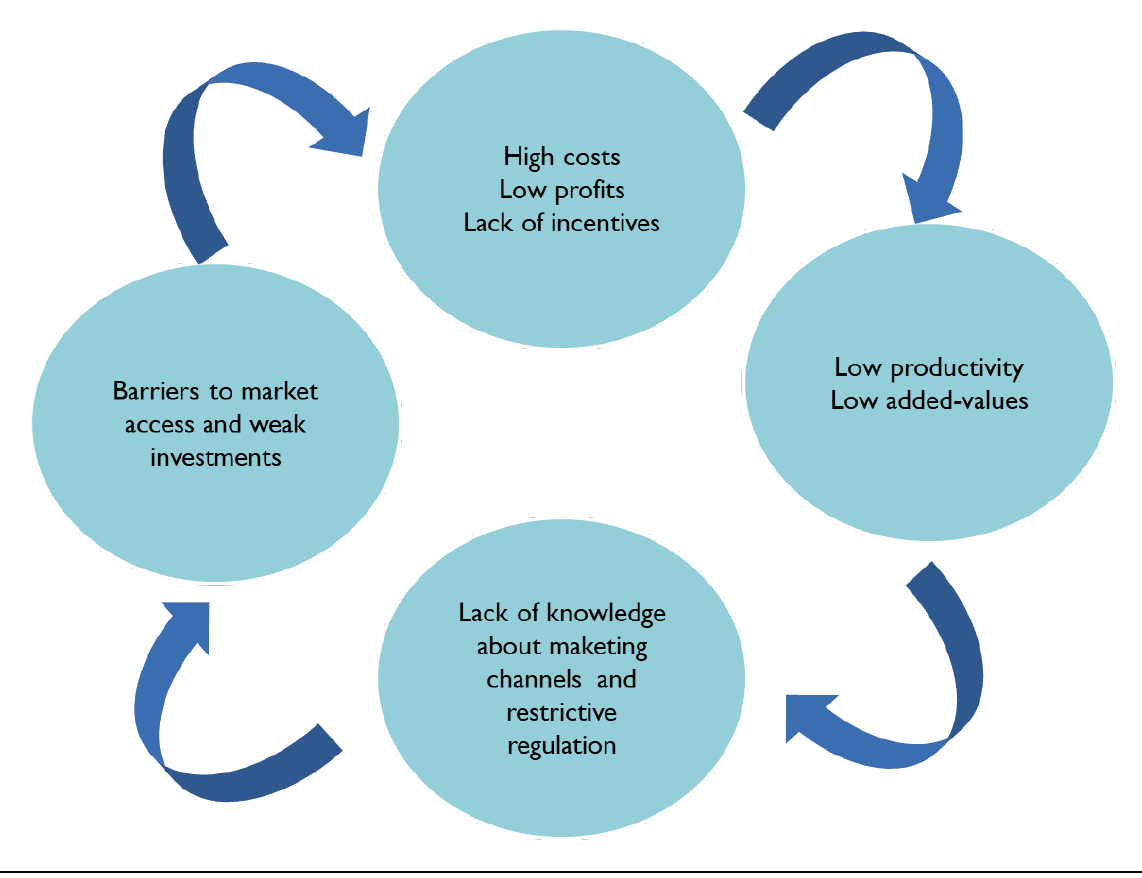
the table. (Land use representative)